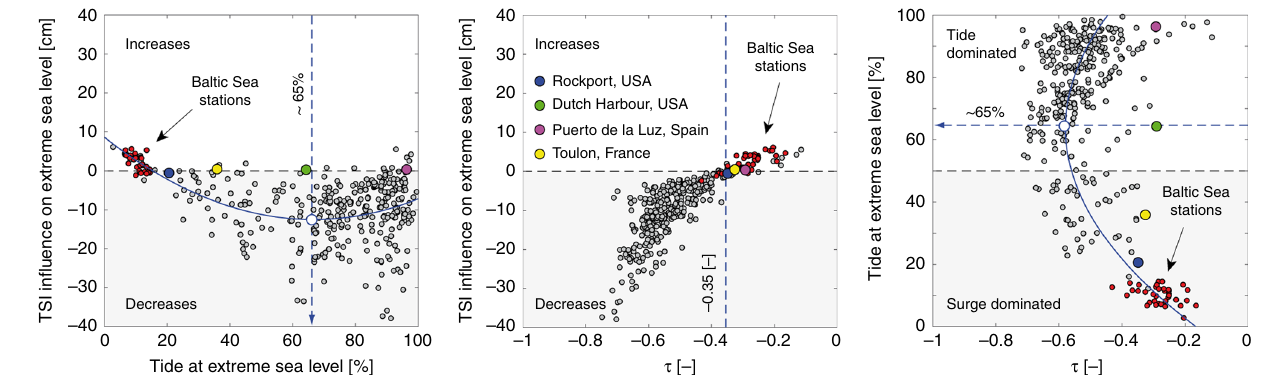
Fig. 1 Max. non-linear effects on extreme sea levels. The fi gure indicates how non-linear changes extreme sea levels (de fi ned here as the 99th percentile threshold exceedances) for ( a ) the entire World, ( b ) Europe, ( c ) Japan, and ( d ) the USA. Water level decreases from non-linear effects are shown in red (i.e., water levels are lower than from a linear superposition of tide and non-tidal residual alone) and increases in blue. Tidal range has been derived